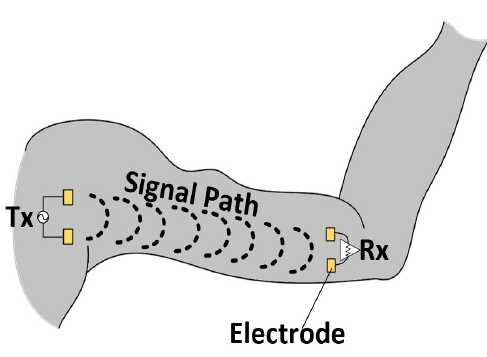
Figure 1: Electrode configuration for galvanic coupling HBC.